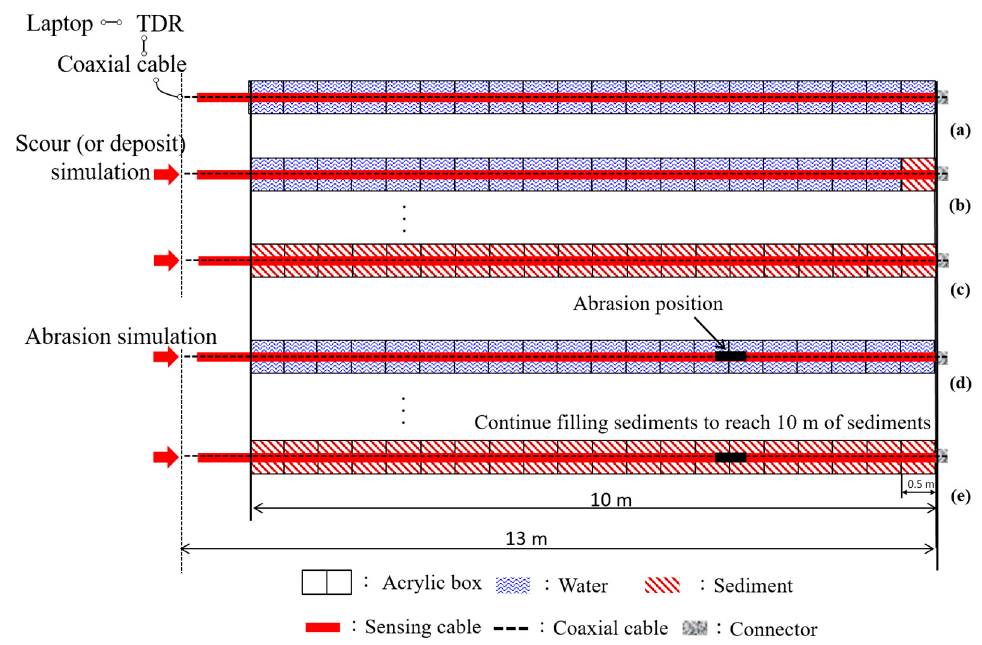
Figure 10. Illustration of the testing procedure of the full-scale scour simulation experiment: ( a – c ) testing sequence for the intact TDR sensing cable; and ( d , e ) testing sequence for the TDR sensing cable with coating abrasion.